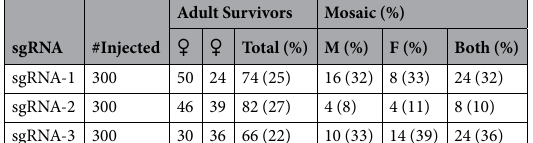
Table 2. Summary of the injection and mutagenesis mediated by independent sgRNAs in N . vitripennis .